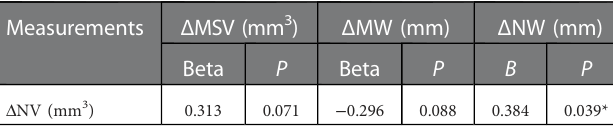
TABLE 4 Multiple linear regression analysis for nasal cavity change. Measurements